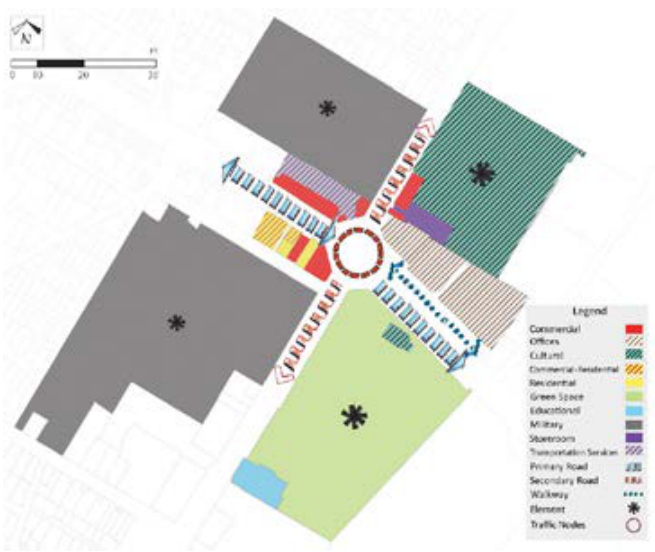
Fig. 5: Cognitive map of Hafeziyeh intersection; source: authors